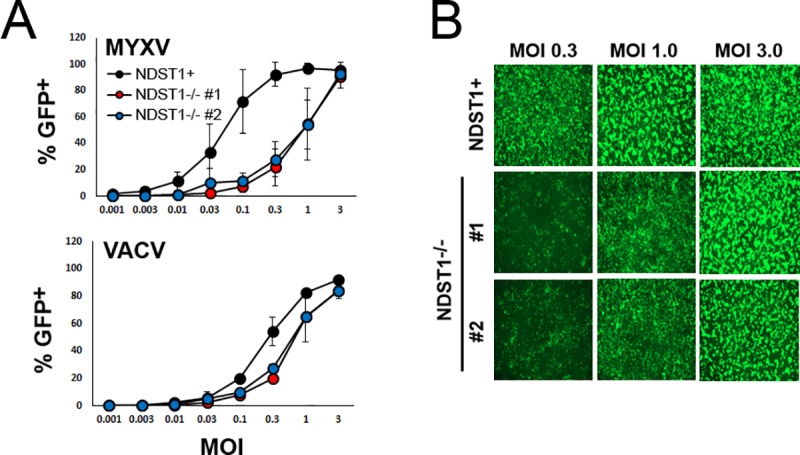
Loss of sulfation reduces initial infection of both MYXV and VACV.(A) Number of GFP+ cells found 24 hours after infection with either MYXV or VACV at multiple MOI’s. Data shown is the summation of two independent experiments each conducted in triplicate. (B) Fluorescent images of cells infected for 24 hours with MYXV at an MOI of 1, 3, and 9 shown as an example.